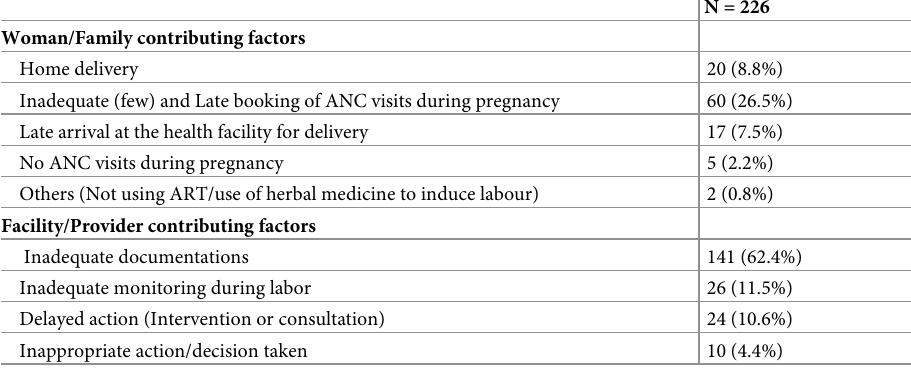
Table 5. Identified contributing